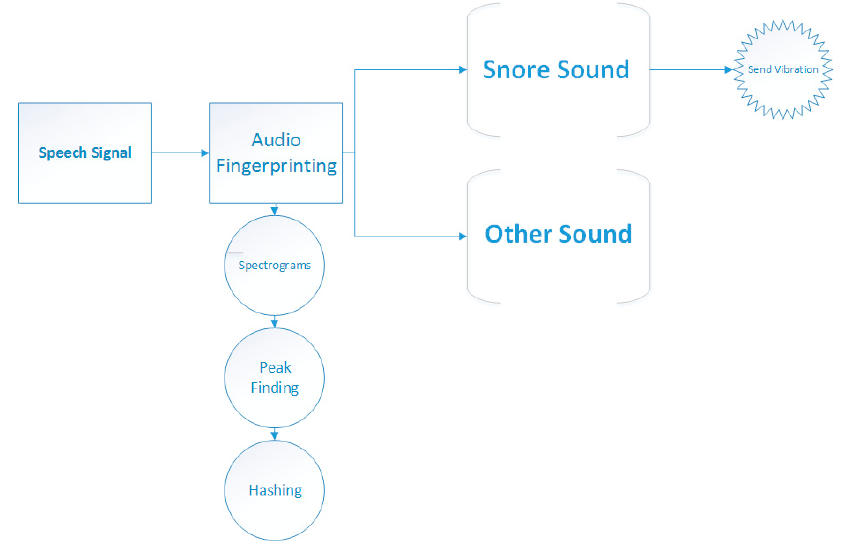
Figure 4. SNORAP Working Mechanism.